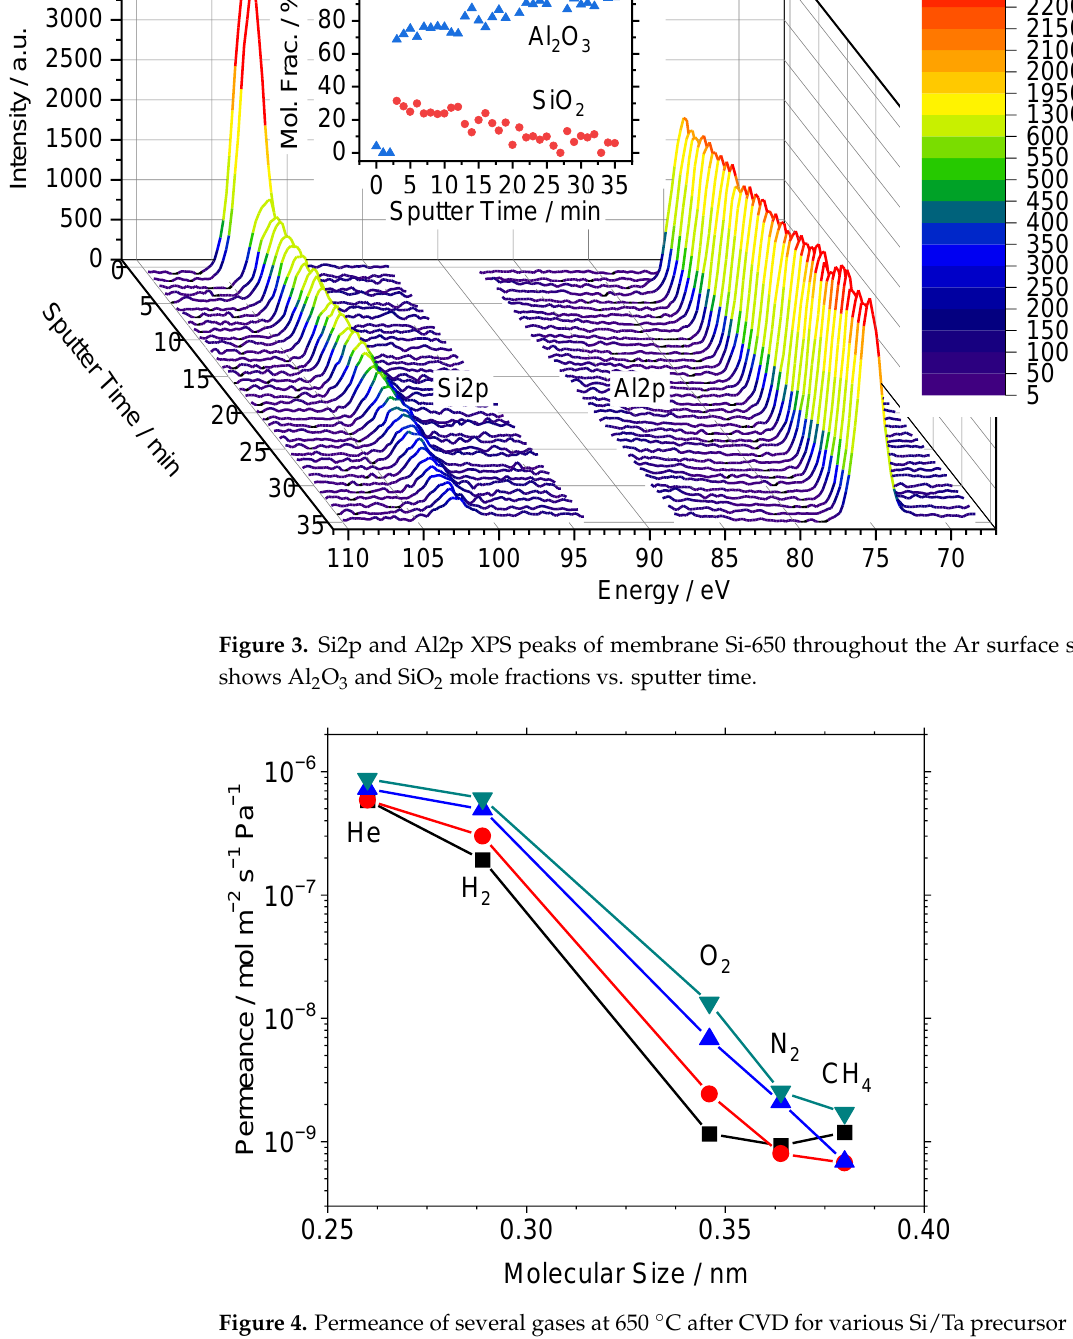
Figure 5. ( a ) Permeance of H 2 and O 2 vs. CVD time at 650 °C for the various Si/Ta precursor ratios. ( b ) Permeance of CH 4 vs CVD time at 650 °C for the various Si/Ta precursor ratios. Legend: Si-650 [ ■ ], Si-3Ta-650 [ ● ], Si-10Ta-650 [ ▲ ], Si-40Ta-650 [ ▼ ]. 3.4. Thermal vs. Reactive Deposition To better understand the deposition behavior, CVD was conducted under both ther- mal deposition conditions involving only Ar gas and reactive deposition conditions using O 2 gas (Figure 6). Because the Si-10Ta-650 membrane showed the highest selectivities (H 2 /CH 4 of 720, O 2 /CH 4 of 10 measured at 650 °C), the TaEO/TEOS ratio of 0.10 was used for these depositions. The O 2 oxidized TEOS and TaEO, which significantly reduced the